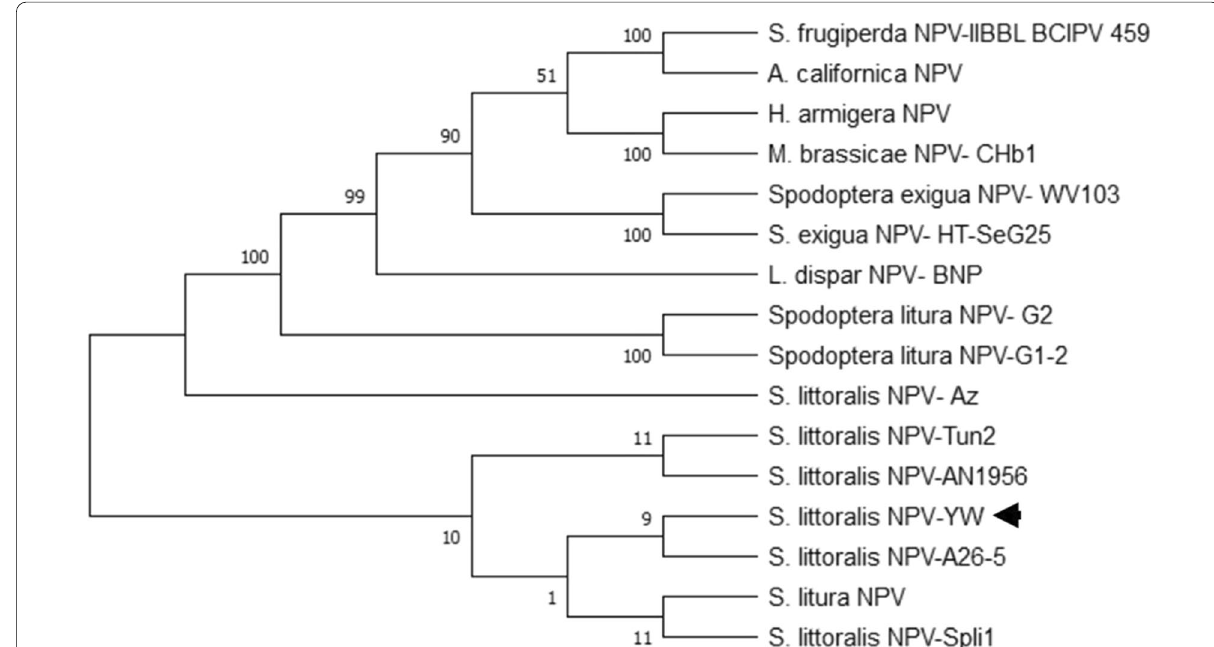
Fig. 5 Phylogenetic analysis of polh gene nucleotide sequence of SpliNPV-YW isolate compared to 15 baculoviruses polh gene published sequences. Multiple sequences alignment and phylogenetic tree were generated using MEGA-X multiple sequence alignment program. Black Arrow indicates the SpliMNPV-YW isolate